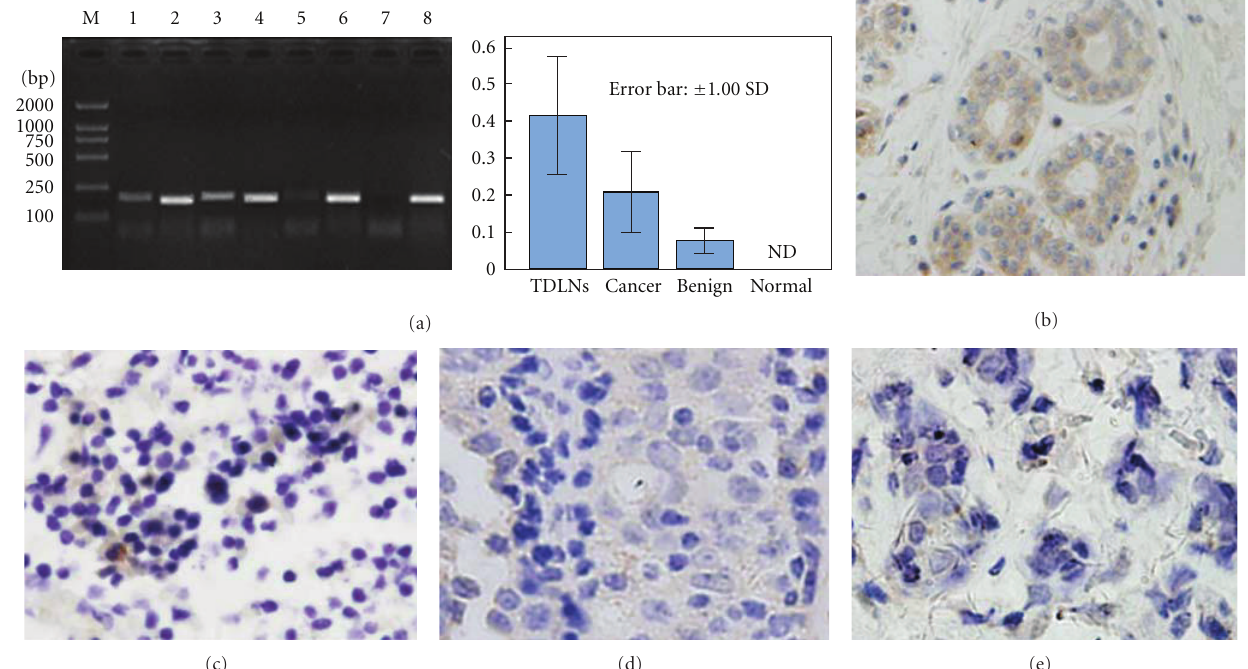
Figure 1: IDO expression in PTs and TDLNs was higher than that in benign diseases at both mRNA and protein levels. The expression of IDO in 26 cases of breast cancer PTs, TDLNs, and normal adjacent tissues and 10 cases of benign breast diseases was detected using qRT- PCR assay and IHC staining method. (a) The IDO mRNA expression in PTs was higher than that in benign diseases but lower than that in TDLNs using the grayscale density ratio of IDO/ β -actin (lane 1: IDO in PTs; lane 2: β -actin in PTs; lane 3: IDO in TDLNs; lane 4: β -actin in TDLNs; lane 5: IDO in benign diseases; lane 6: β -actin in benign diseases; lane 7: IDO in normal tissues; lane 8: β -actin in normal tissues; M: DL2000 marker). (b)–(e) The IDO protein was predominantly expressed on cancer cells in breast cancer PTs (b) and in myeloid cell-like karyocytes in TDLNs (c), while less IDO expression was found in mammary ductal cells with hyperplasia in benign diseases (d). No IDO protein expression was detected in normal adjacent tissues